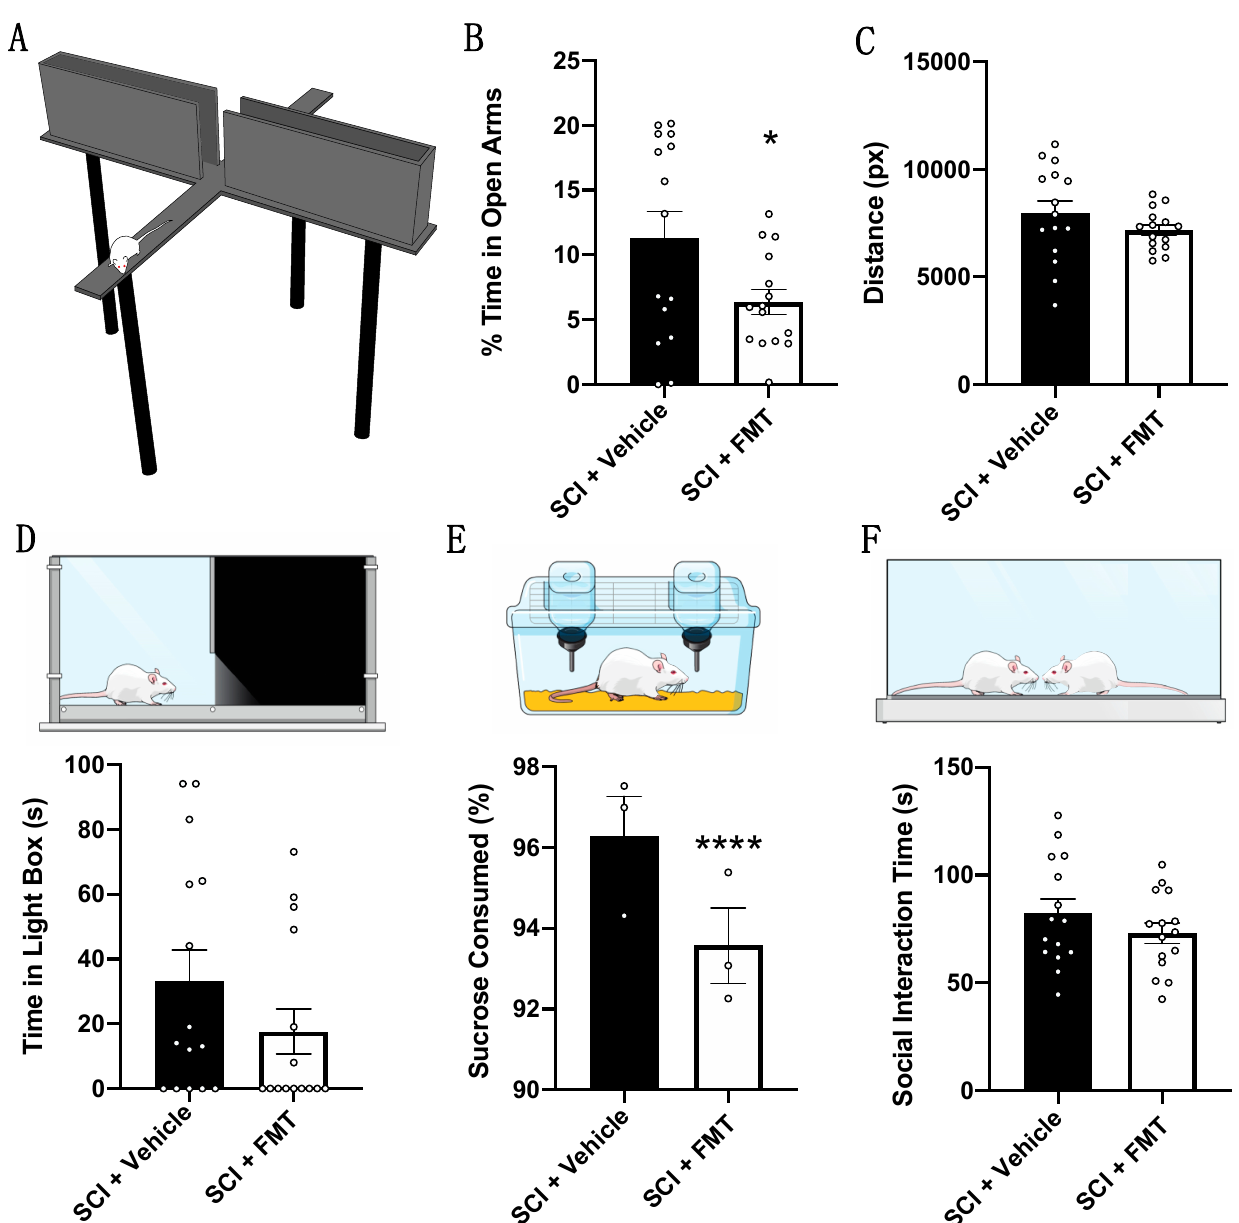
Figure 6. FMT from anxious donors resulted in a chronic increase in anxiety-like behaviour after SCI. At the end of rehabilitative training, rats were tested for anxiety-like and depressive-like behaviours. ( A ) Schematic of a rat in the open arm of the elevated plus maze. ( B ) SCI + FMT rats spent significantly less time in the open arms compared to untreated rats. ( C ) Both groups of rats travelled a similar amount of distance in the elevated plus maze. ( D ) SCI + FMT rats spent less time in the light-component of the light-dark box and ( E ) drank less sucrose water than untreated rats (each data point represents a cage containing 5 rats, each of which were considered for statistical analyses). ( F ) Both fecal transplant treated and untreated rats spent a similar amount of time interacting in the social interaction test. * p < 0.05, **** p < 0.0001. Error bars represent standard error mean.